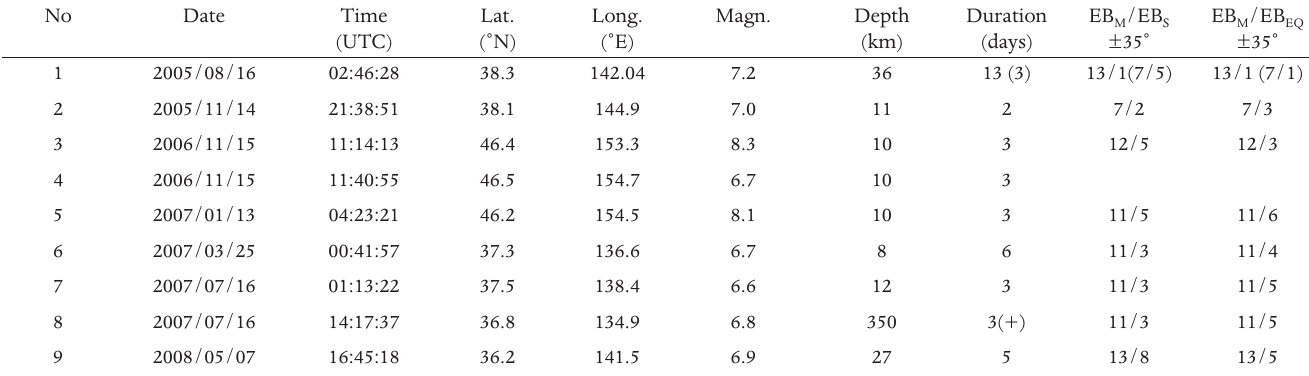
Table 1. Characteristics of the earthquakes with M >6.7 in the greater region of